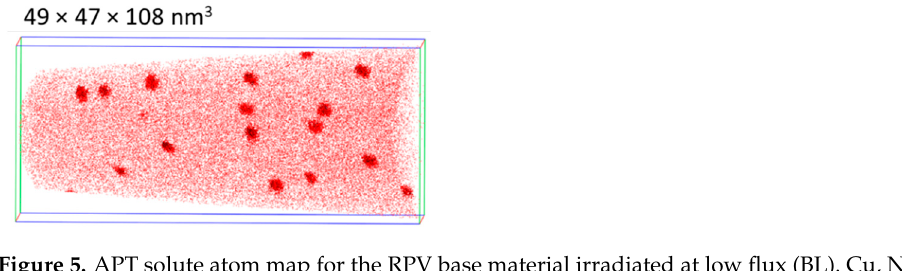
Figure 5. APT solute atom map for the RPV base material irradiated at low flux (BL). Cu, Ni and Si atoms are represented in red. Clusters are highlighted using a slightly higher threshold of 5.2 at%.